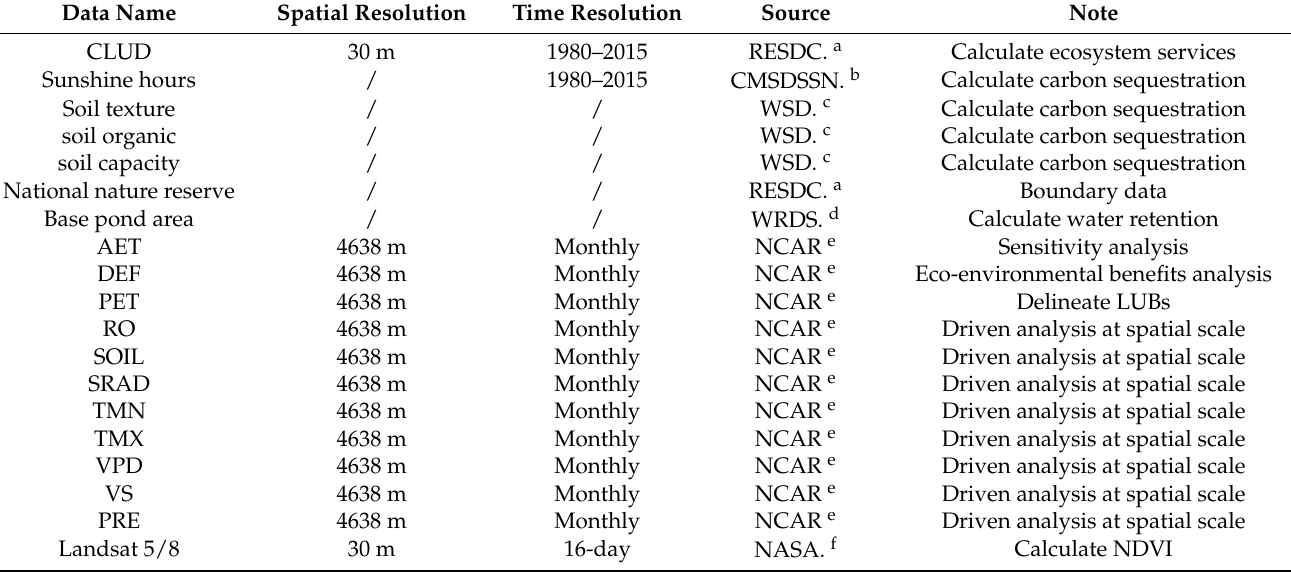
Table 1. Detailed description of the